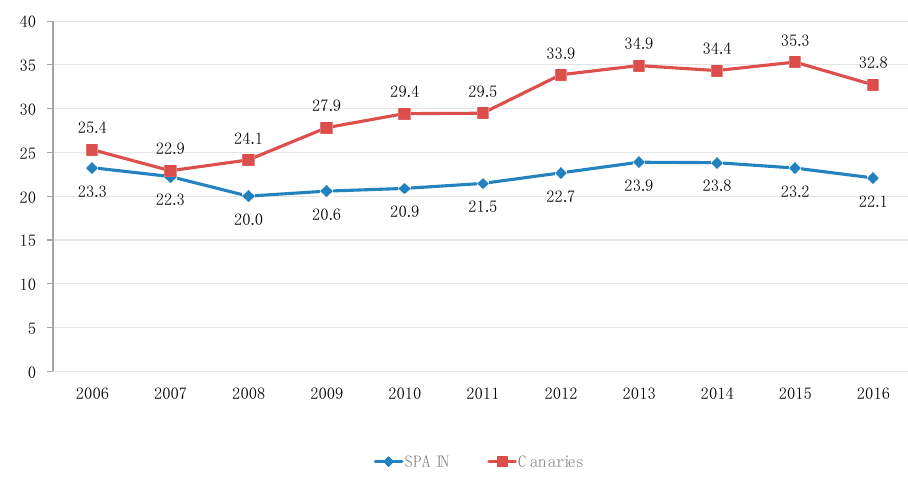
Figure 2. Trend of poverty annual rate in Spain and the Canaries (%).